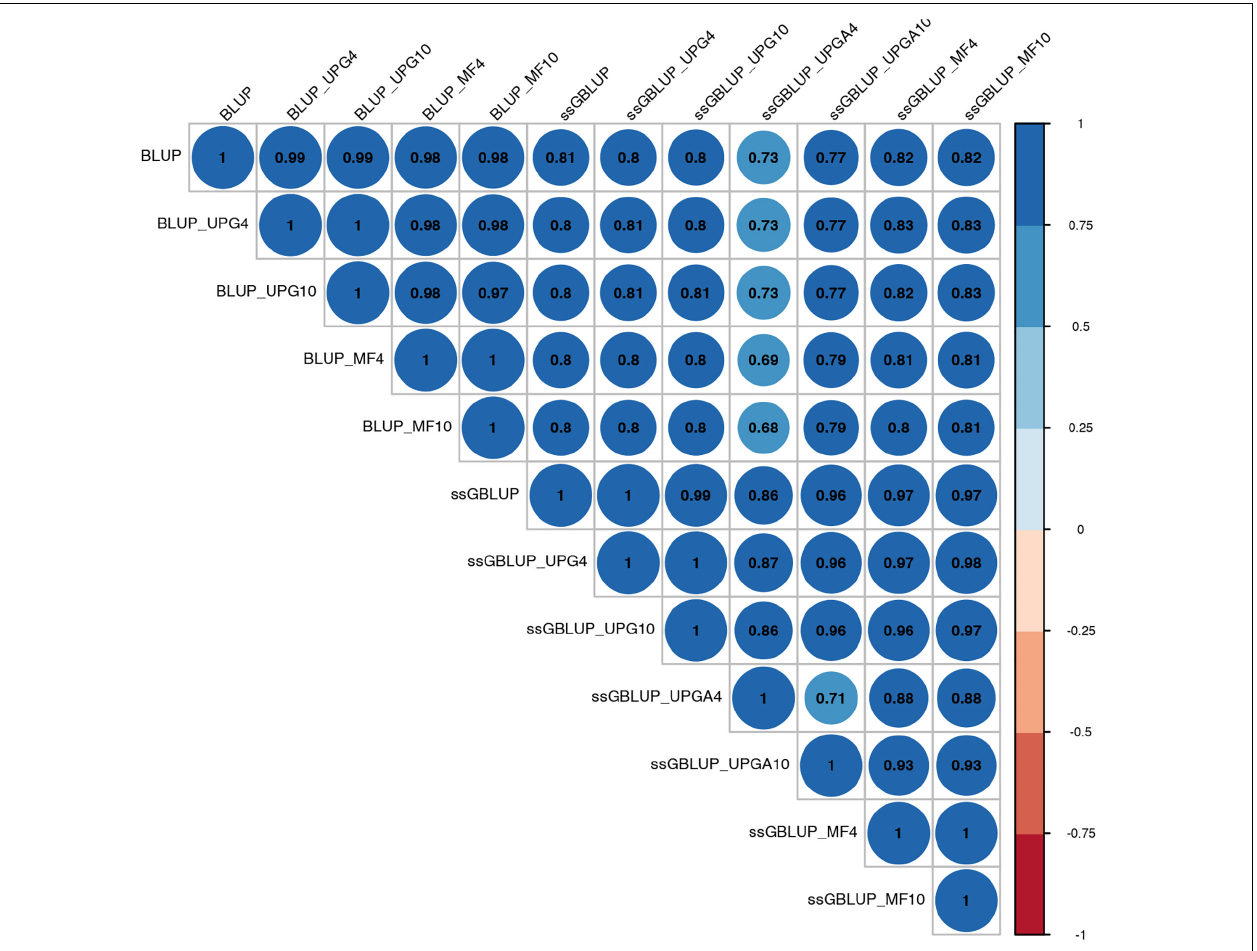
FIGURE 5 | Correlations between breeding values for birth weight direct estimated using various models with and without genetic